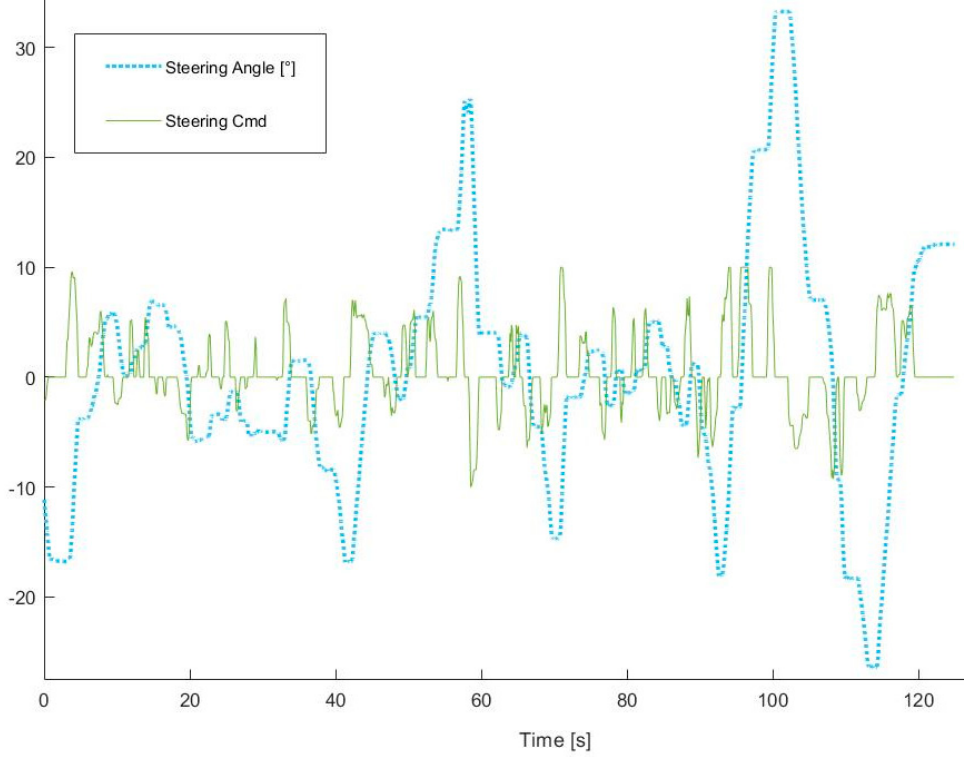
Figure 18. Human operator steering commands and LHD steering angle on dataset M1.